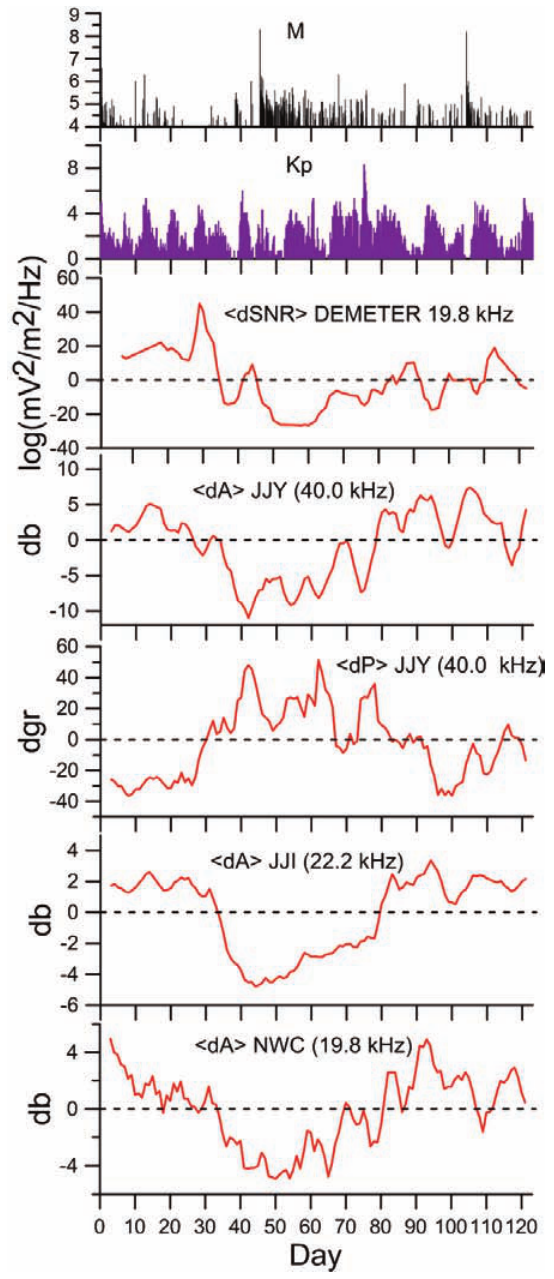
Figure 5. Comparison of the ground and satellite observations during October 2006 to January 2007. For the satellite observations averaged along parts of the orbits, the VLF signal differences from the reception of the NWC transmitter signal are shown. For the ground observations averaged through the night-time, the VLF/LF signal differences are shown for the wave paths: JJY-Petropavlovsk-Kamchatsky (amplitude and phase), JJI-Petropavlovsk-Kamchatsky and NWC-Petropavlovsk-Kamchatsky. The X axis shows the days beginning from October 1, 2006. Two upper panels, earthquake magnitudes, and Kp indices of the magnetic